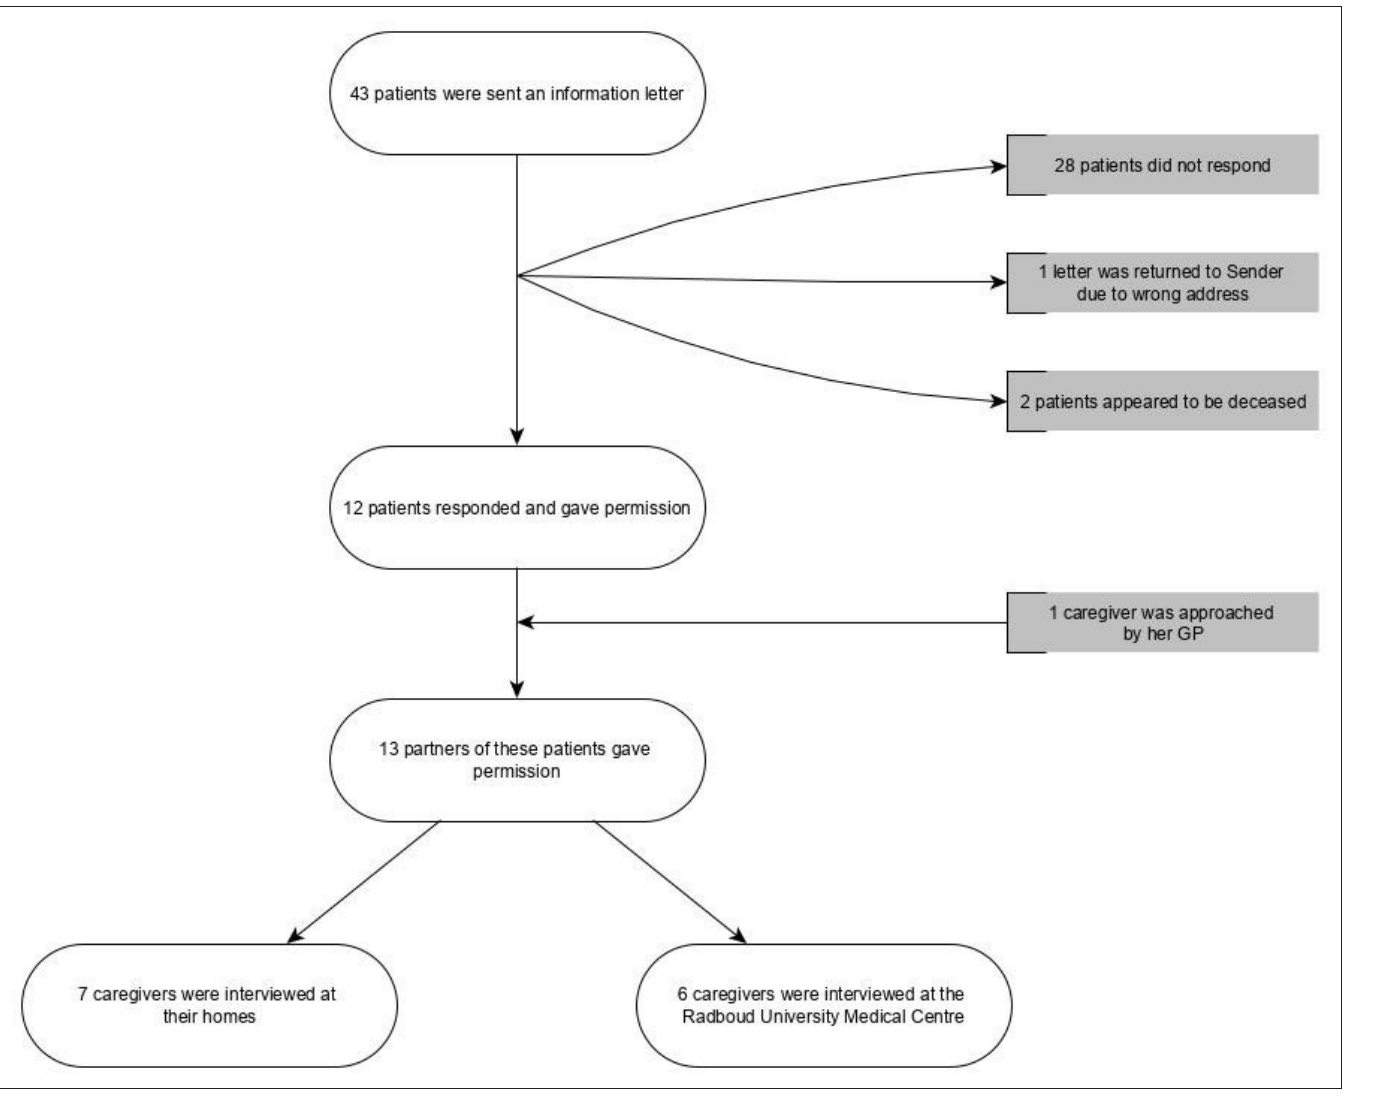
Figure 1 Flowchart: recruitment of